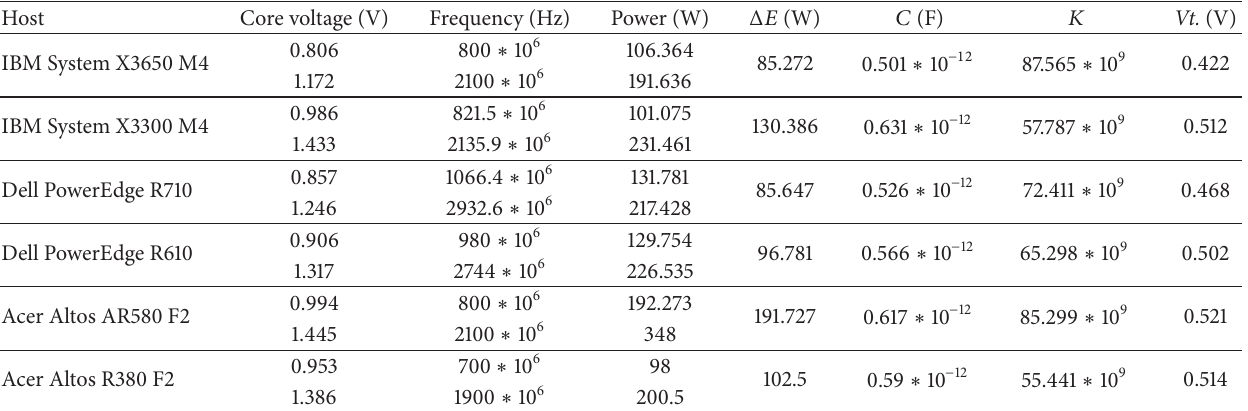
Table 4: Parameters summary of host models.